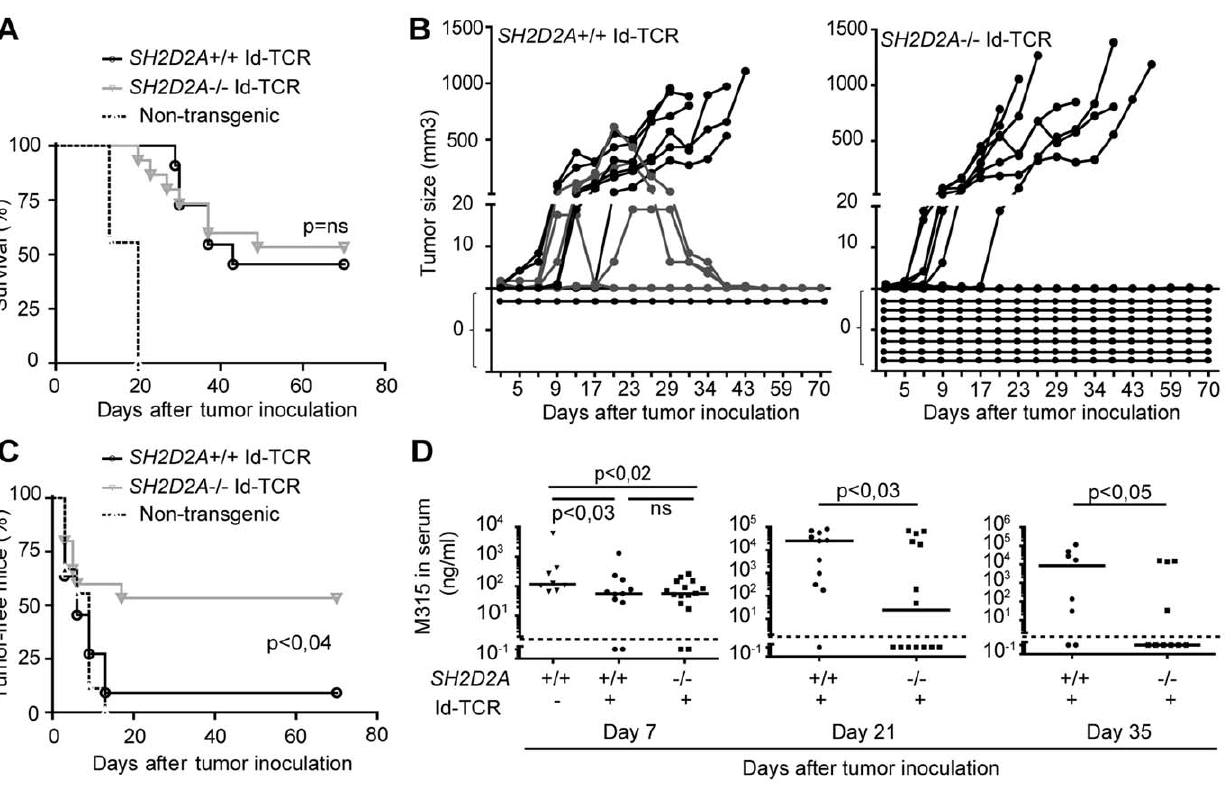
Figure 6. TCR transgenic SH2D2A -deficient mice are also resistant towards tolerizing amounts of myeloma. Id-specific TCR transgenic mice with ( + / + , n=11) or without (-/-, n=15) SH2D2A expression were injected subcutaneously with high dose (2 6 10 6 ) MOPC315 cells. Tumor development was followed by palpation (A–C) and M315 serum myeloma protein concentration was measured by ELISA 7, 21 and 35 days after tumor inoculation (D). (A) The plot display survival of Id-specific TCR-transgenic mice with and without SH2D2A . Mice with large tumors (tumor volume . 1 cm 3 ) were euthanized. (B) The graphs display the tumor growth in the individual Id-specific TCR transgenic mice with ( + / + , left diagram) and without ( 2 / 2 , right diagram) SH2D2A expression. The grey lines highlight established tumors that were rejected. The horizontal lines at 0 mm 3 visualize mice that did not develop a palpable tumor during the course of the experiment. (C) The plot displays tumor take of SH2D2A + / + and SH2D2A 2 / 2 Id-specific TCR-transgenic mice. A tumor-free mouse was defined as a mouse that has not had a palpable tumor during the course of the experiment. (D) The plots present the M315 serum level 7, 21 and 35 days after tumor cell inoculation. Lines represent the median values of the M315 measurements. The dots below the dashed line (at 2 ng/ m l) are below the detection limit of the ELISA assay. P values were calculated with two-tailed log rank test (A, C) and one-tailed Mann-Whitney U test (D). Ns=non-significant.